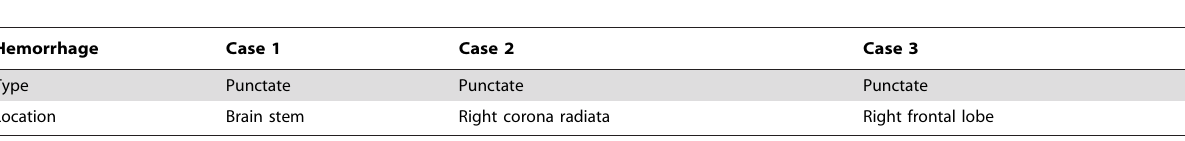
Table 2. Description of the type and location of the hemorrhages detected by